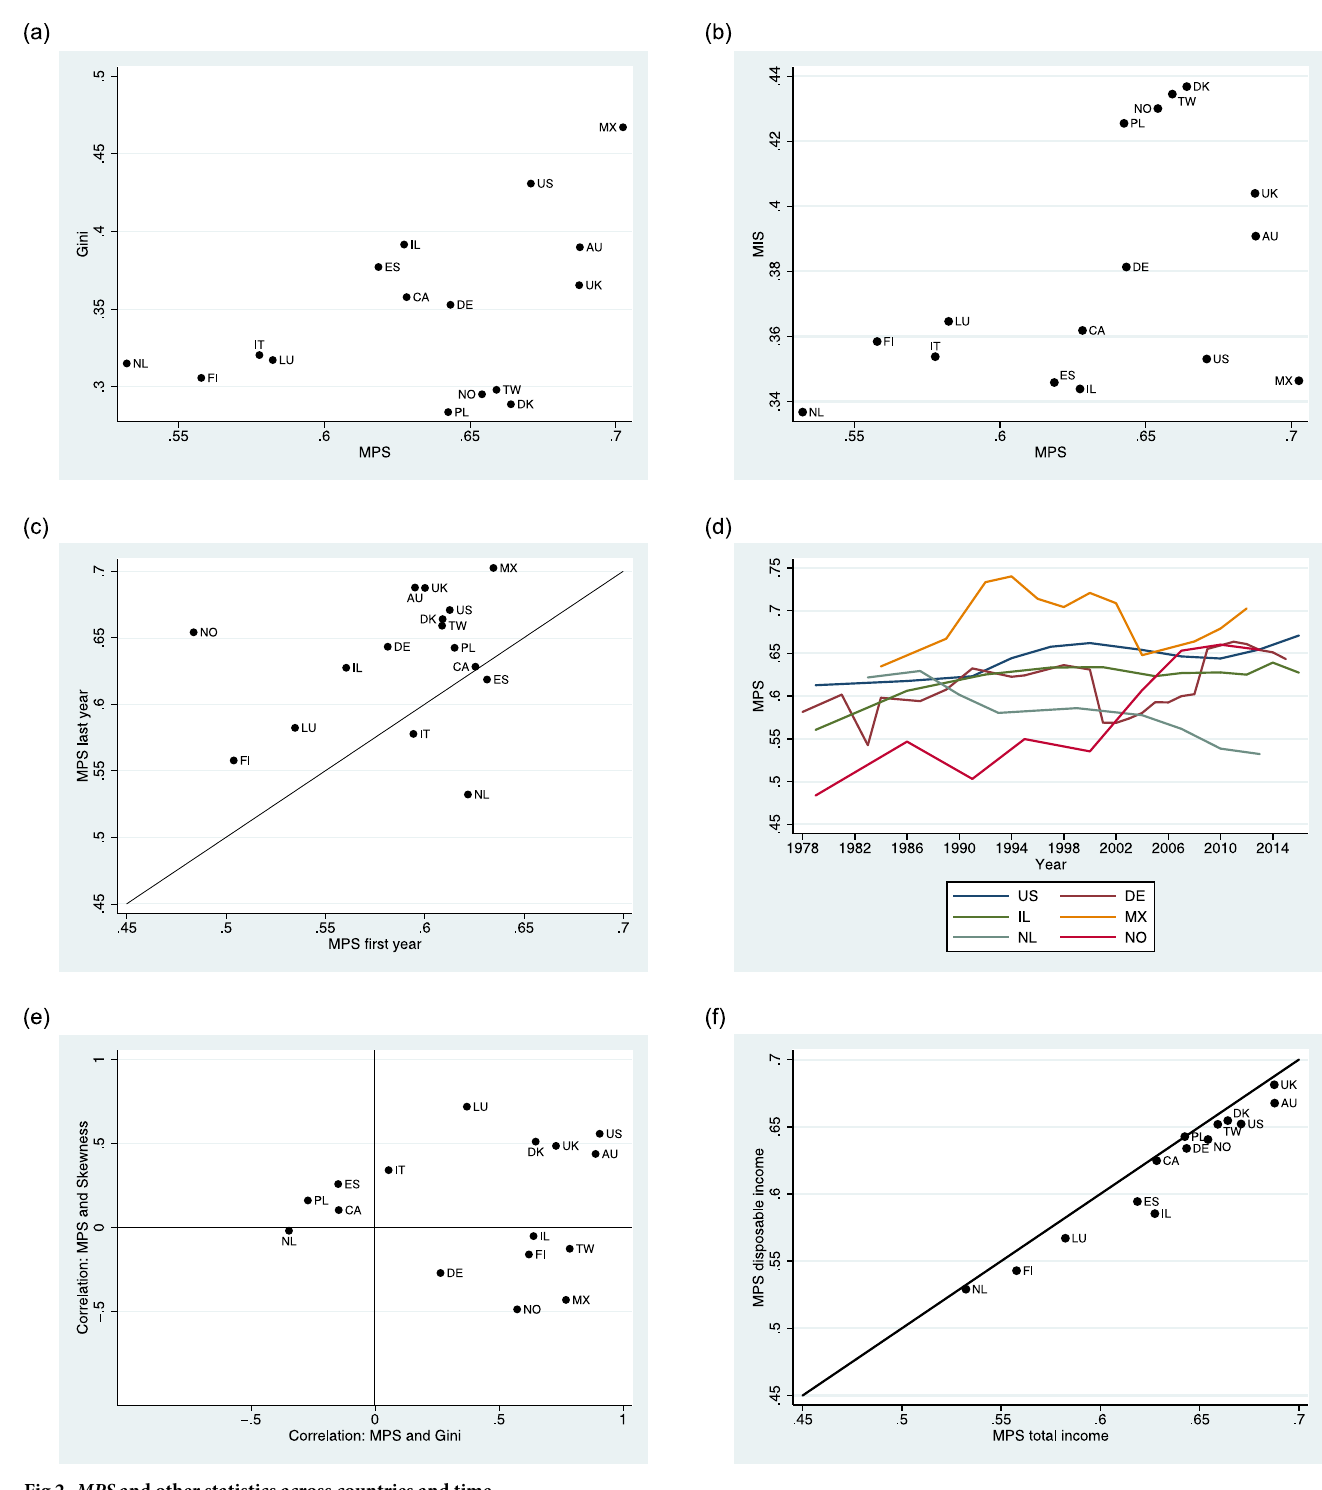
Fig 2. MPS and other statistics across countries and time.